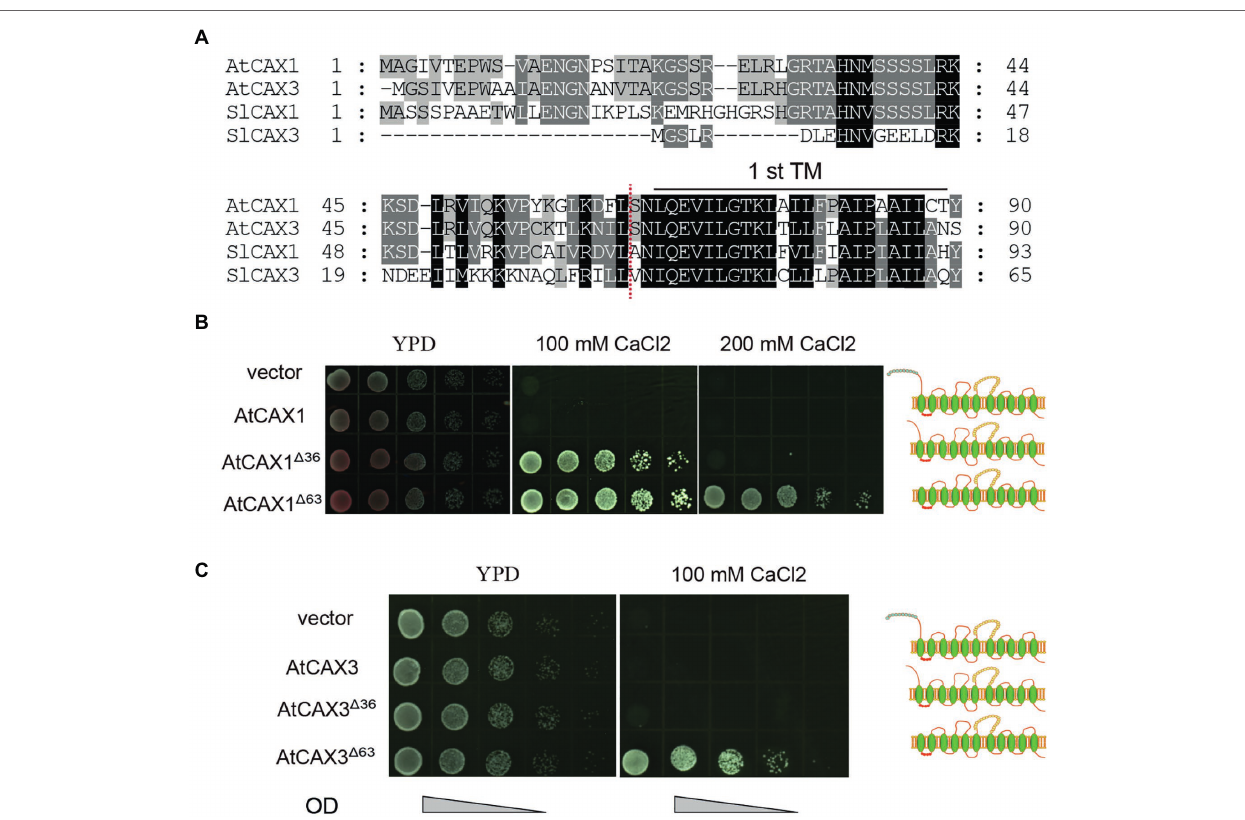
FIGURE 5 | Truncating the amino acids before the first TM further increases the activity of CAX1 and CAX3. (A) Alignment of deduced amino acid sequences of polypeptides encoded by Arabidopsis CAX1 and CAX3 and tomato SlCAX1 and SlCAX3 (partial). Consensus amino acid residues are boxed in black (identical) or grey (similar). Gaps introduced to maximize the alignments are denoted by hyphens. The amino acids residues before the red dotted lines are deleted to form AtCAX1 Δ 63 and AtCAX3 Δ 63 . (B,C) Truncated AtCAX1 and AtCAX3 were expressed in yeast mutant strain K667, respectively. The cultures were diluted 10, 100, 1,000, and 10,000 times from OD 1.0, respectively, and an equal amount of sample was pipetted onto yeast YPD medium with or without CaCl 2 . The yeast cells were cultured at 30 ° C for 3 days.